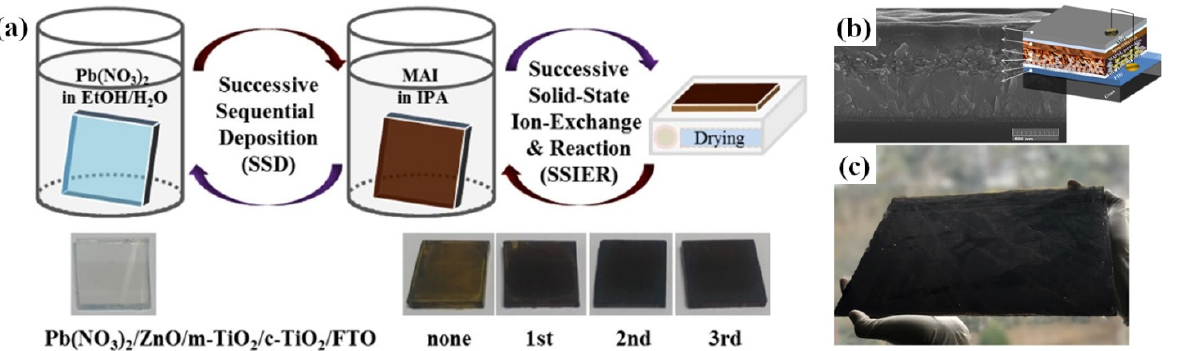
Figure 14. ( a ) Schematic diagram for the preparation of perovskite films using dipping of ZnO covered m-TiO 2 /c-TiO 2 /FTO